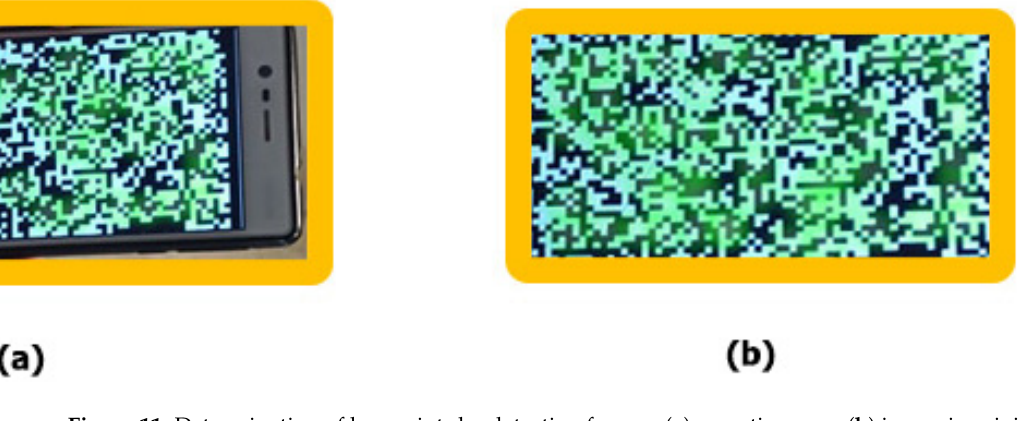
Figure 11. Determination of key points by detection frames; ( a ) reception area, ( b ) image in original format.